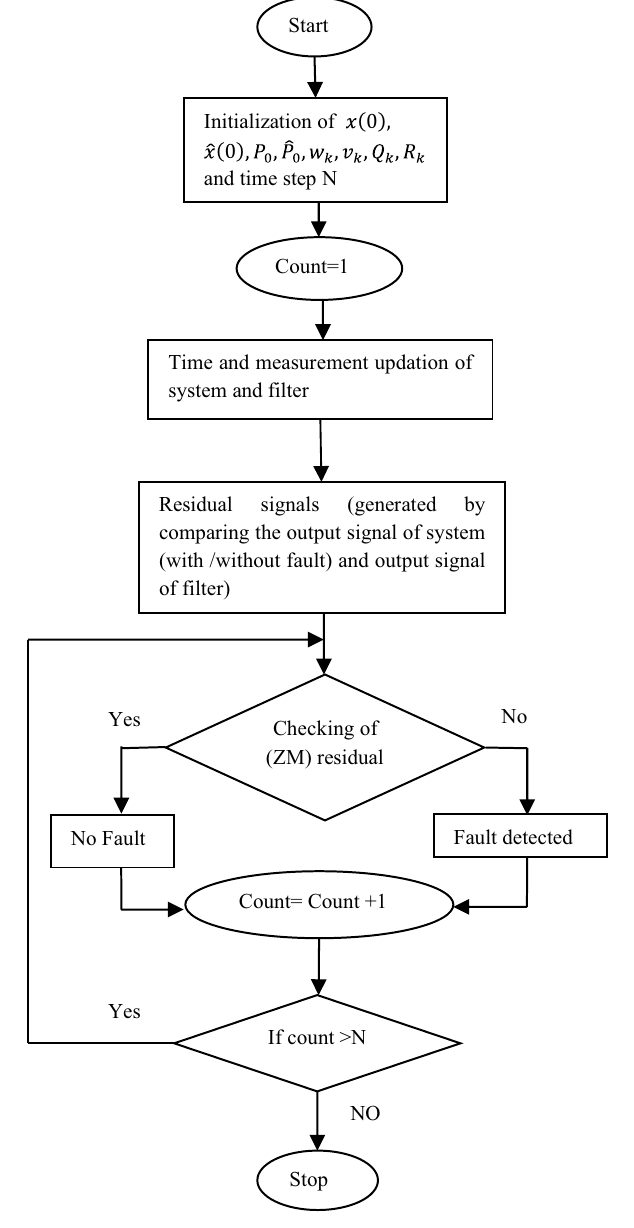
Figure 2. Residual based multiple fault diagnosis algorithm using